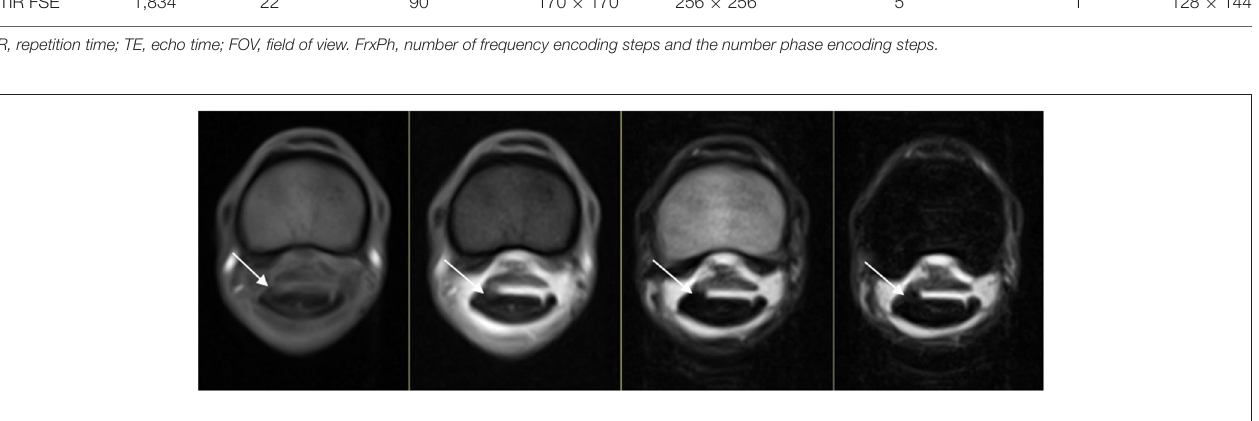
FIGURE 1 | From left to right, T1WGRE, T2*W GRE, T2WFSE, and STIR FSE images of a dorsolateral DDFT injury at the level of the proximal phalanx where the DDFT goes from ovoid to bilobed in an RF limb (lateral is to the left). The injury is evident on all sequences (white arrow) and is of intermediate SI on T1WGRE and T2*WGRE and low SI on T2WFSE and STIR FSE